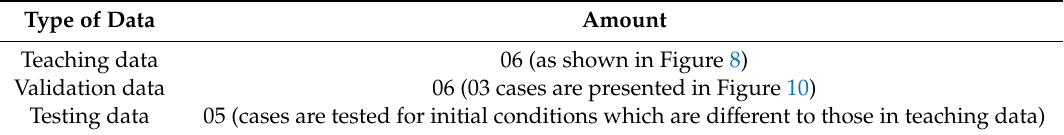
Table 4. The list of teaching data/validation data/testing data.